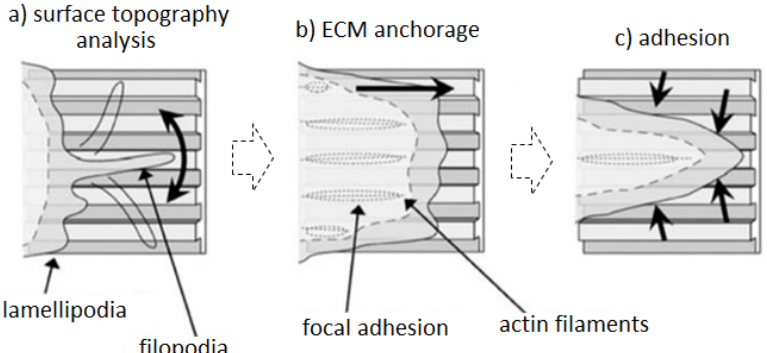
Figure 5. Contact guidance machinery. Lamellipodia extrusions are temporarily exposed following filopodia sensors information ( a ) prior to the surface anchorage by focal adhesions ( b ) and full adhesion by cytoskeleton rearrangement ( c ). (Authors’ own pictures.).